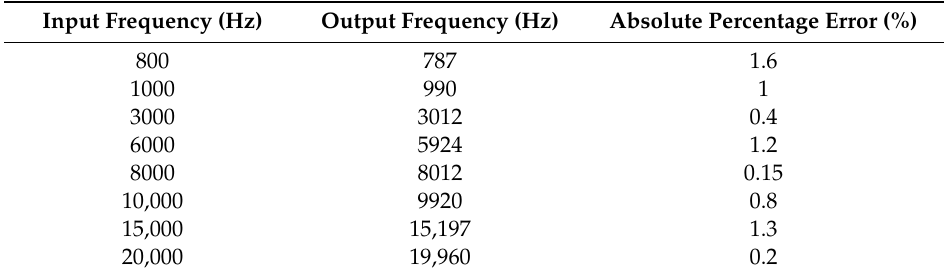
Table 1. Measured frequency of the generated signals from the PVDF NF mat compared to input acoustic signals with percentage error